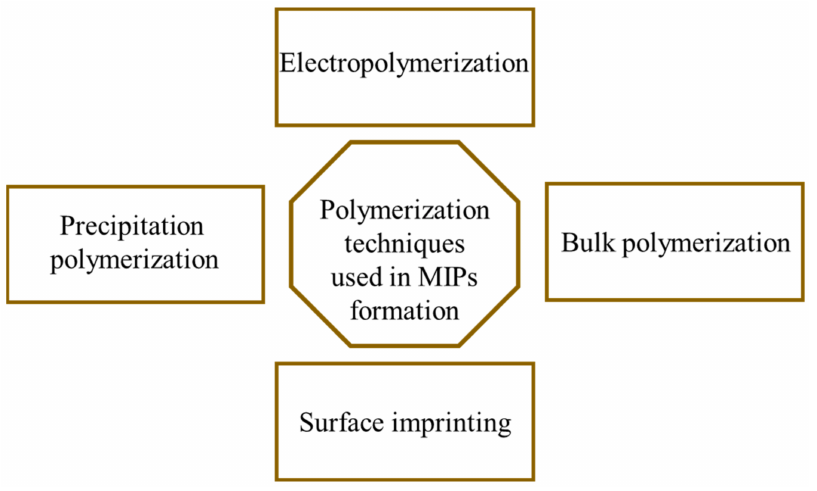
Figure 4. Polymerization techniques used for MIP synthesis for electrochemical sensing of